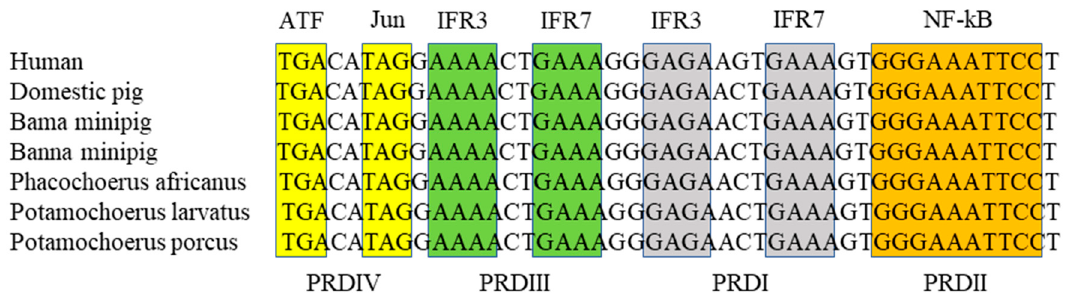
Figure 2. Amino acid sequence alignment of IFN ‐β proteins between different animal species. The cleavage site of signal peptides is indicated with an arrow. Amino acid substitutions are shadowed. The conserved cysteine residues at the indicated positions are dot line-boxed. Putative N -glycosylation sites are solid line-boxed.